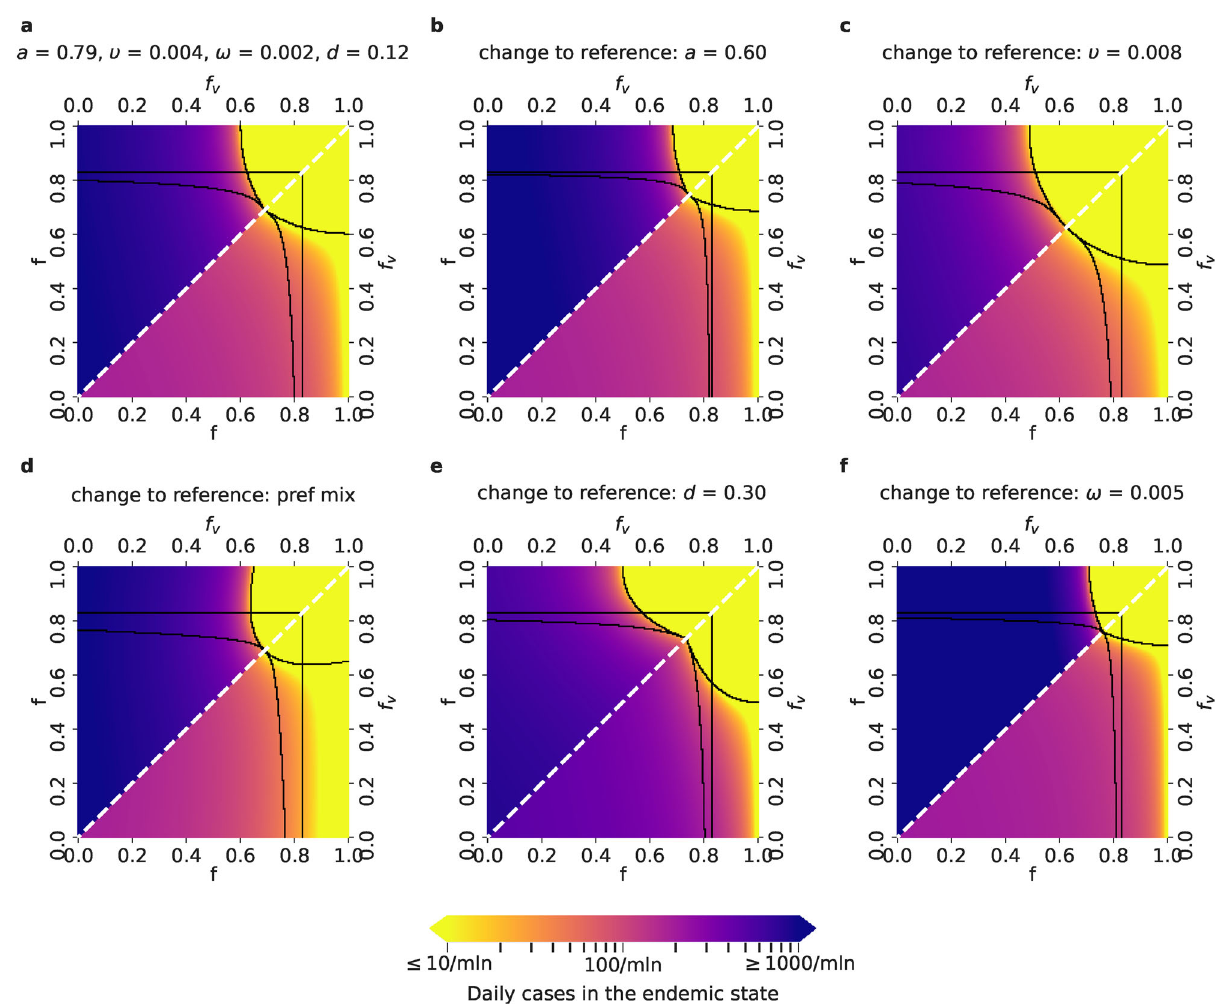
Fig. 3 Daily COVID-19 infection cases in the endemic state for different parameter setups and the Delta variant. Lower triangles show the daily infection numbers in the vaccinated, and upper triangles in the unvaccinated population in the endemic state of the epidemics, for the relevant f − f v parameter space, where f v ≤ f . The color scale spans from no more than 10 (yellow) up to 1000 and more daily cases per million people (dark violet). Parameter setups as well as the black borders that delimit the fi ve regions are de fi ned as in Fig. 2: a Reference setup, with a = 0.79 (corresponding to the effectiveness of the Comirnaty vaccine on the Delta variant), υ = υ r = 0.004, ω = 0.002, d = 0.12 (fraction of never-vaccinated in the United Kingdom) and proportional mixing. b Setup with a decreased vaccine effectiveness: a = 0.6 (corresponding to the effectiveness of the Vaxzevria vaccine on the Delta variant). c Setup with an increased vaccination rate: υ = υ r = 0.008. d Setup with preferential (instead of proportional) mixing. e Setup with an increased fraction of people who will not get vaccinated: d = 0.3 (fraction of never-vaccinated in France). f Setup with an increased waning rate: ω =